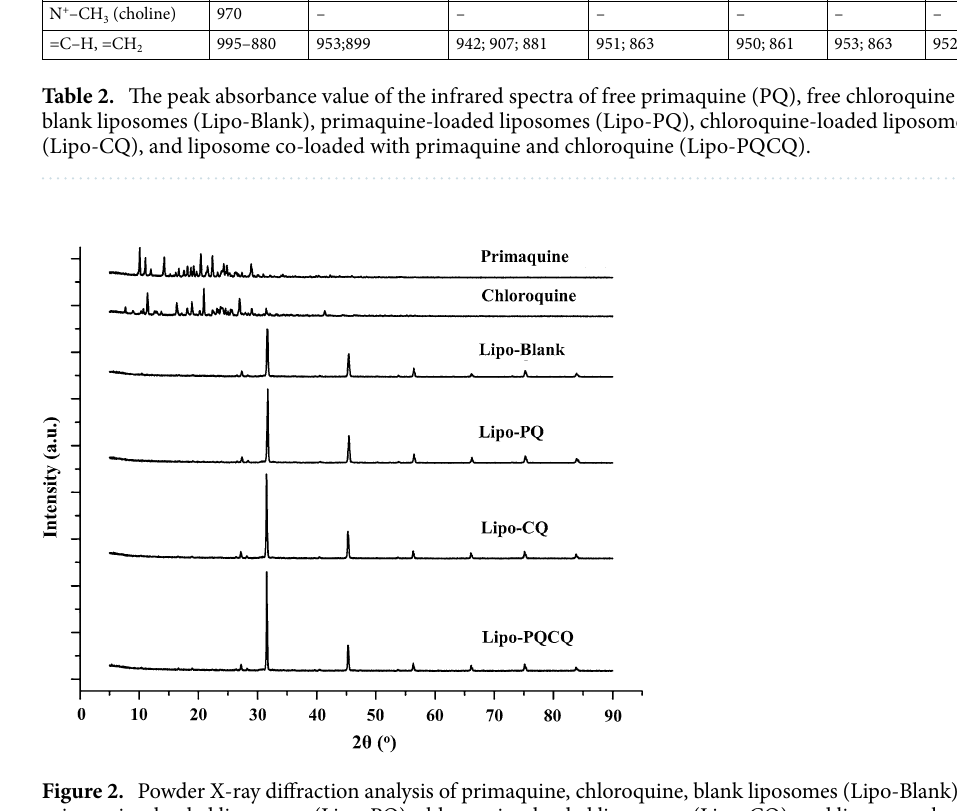
Figure 2. Powder X-ray diffraction analysis of primaquine, chloroquine, blank liposomes (Lipo-Blank), primaquine-loaded liposomes (Lipo-PQ), chloroquine-loaded liposomes (Lipo-CQ), and liposomes loaded with both primaquine and chloroquine